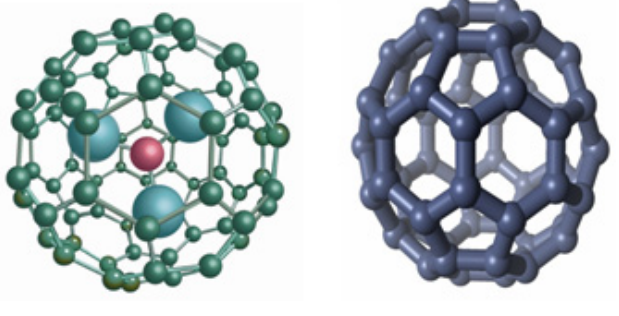
Figure 1. Structures of trimetallic nitride endohedral metallofullerene and empty cage fullerene C